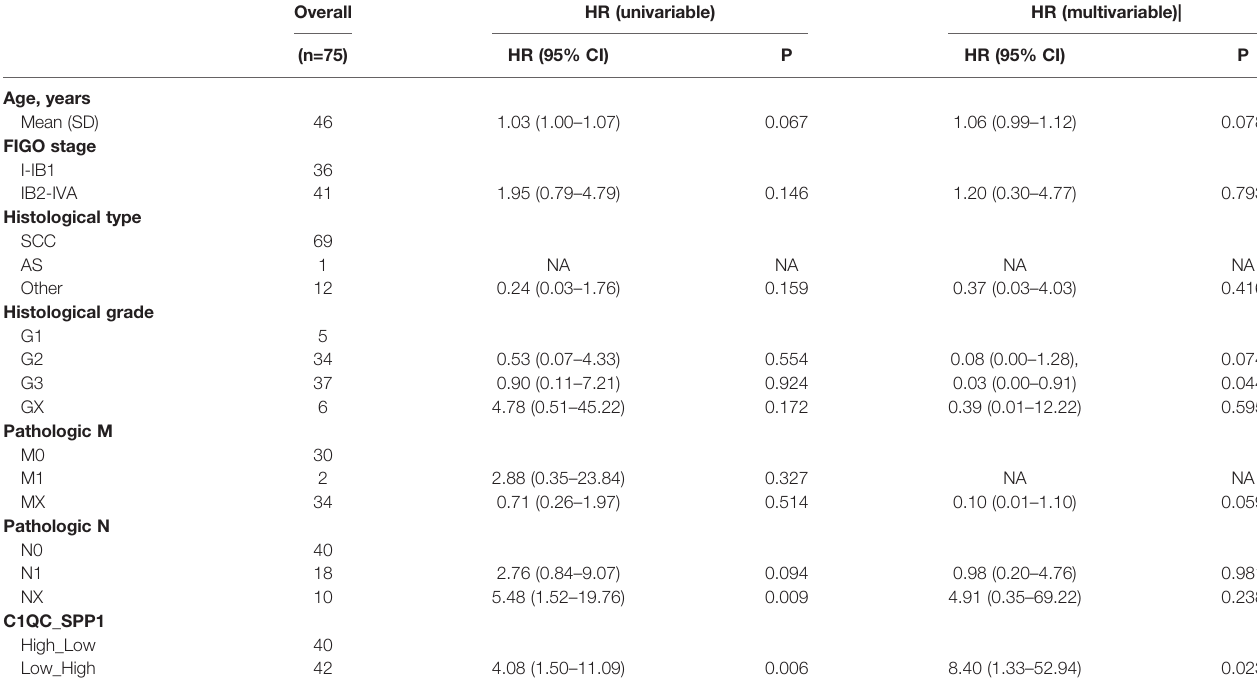
TABLE 2 | Prognostic values of clinical factors and C1QC+ and SPP1+ TAMs gene signatures in cervical cancer.